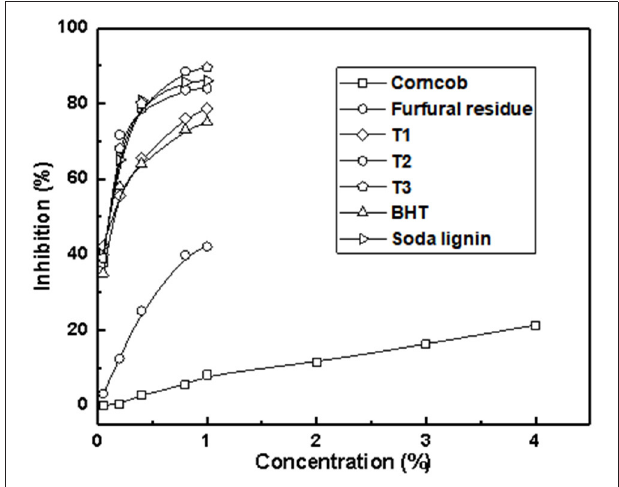
FIGURE 5 | Scavenging activity of lignin samples compared with commercial antioxidants for DPPH radical.